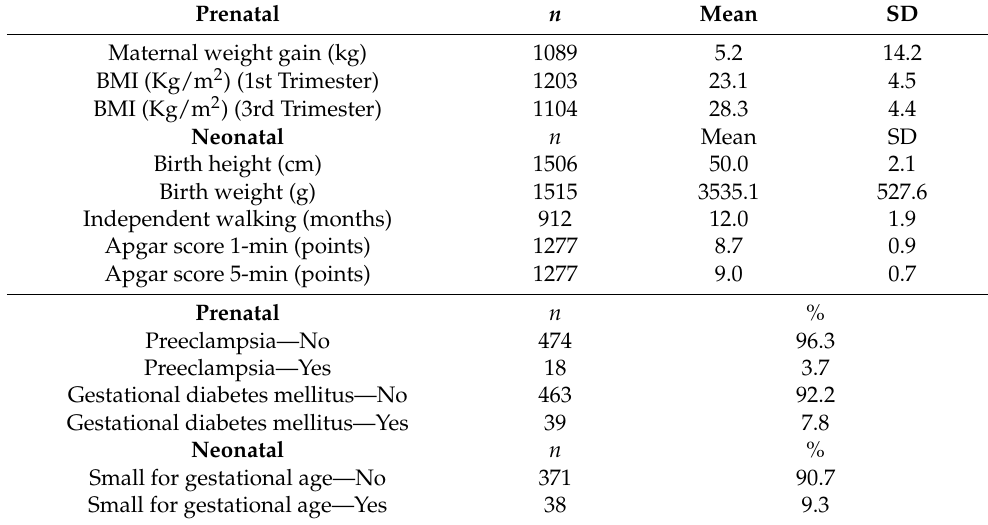
Table 1. Prenatal and neonatal descriptive characteristics of the